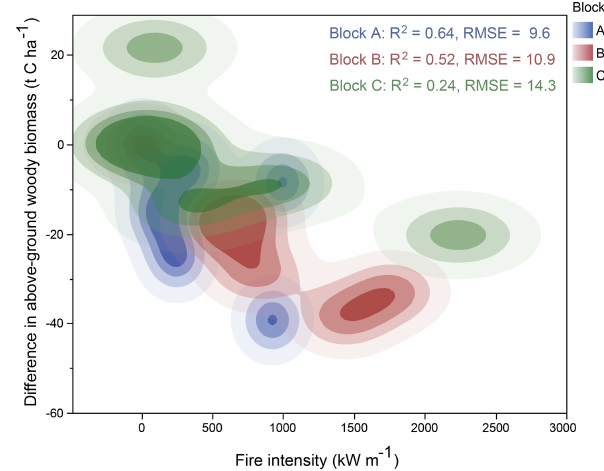
Figure 5. Density plot showing the relationship between increasing fire intensity reduction in woody carbon storage, relative to unburnt plots, for the A (blue), B (red), and C (green)